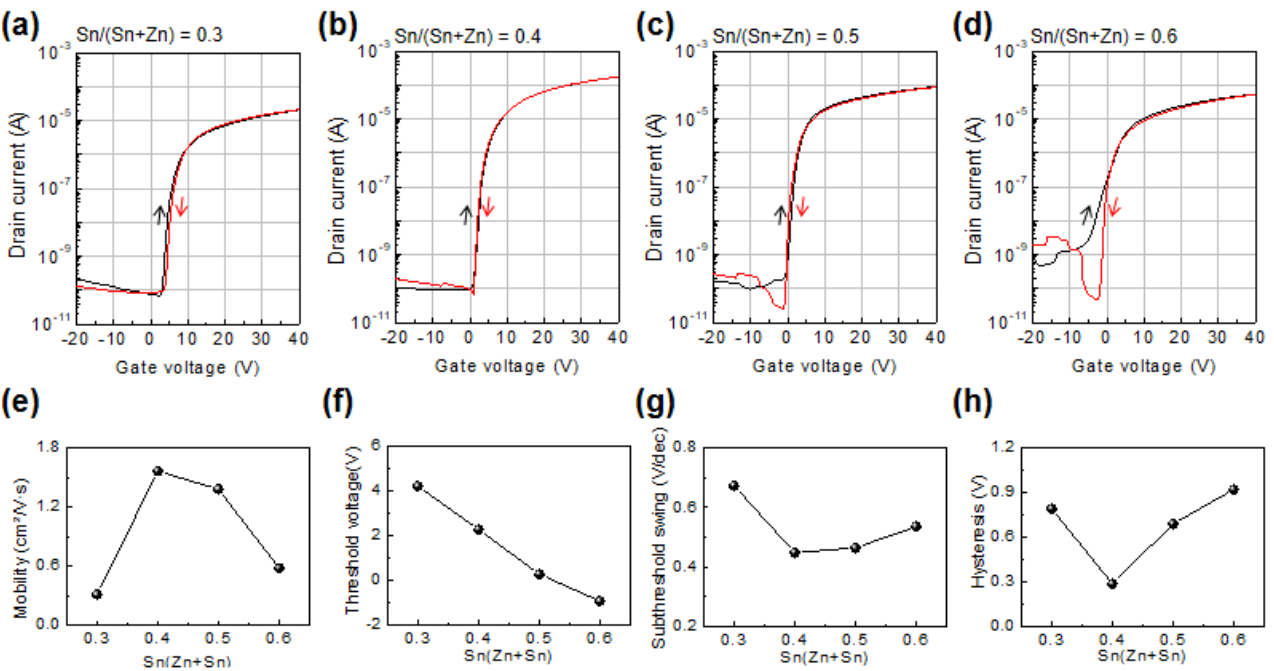
Figure 4. Transfer characteristics of ZTO TFTs with Sn/(Sn+Zn) ratios of ( a ) 0.3, ( b ) 0.4, ( c ) 0.5, and ( d ) 0.6. Black and red lines indicate transfer characteristics with forward and backward sweep, respectively. The detailed plot of Sn/(Sn+Zn) ration regarding ( e ) mobility, ( f ) threshold voltage, ( g ) subthreshold swing, and ( h ) hysteresis.